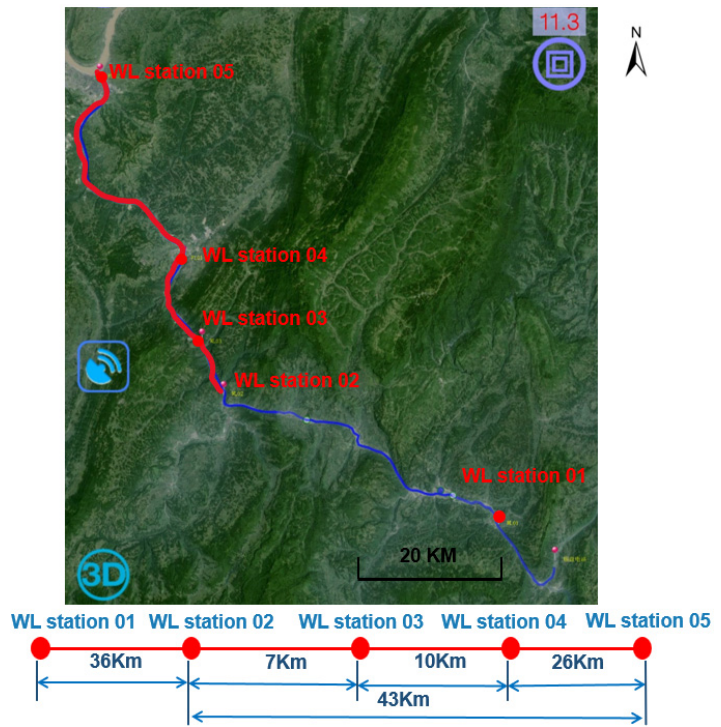
Figure 2. The location of study area.